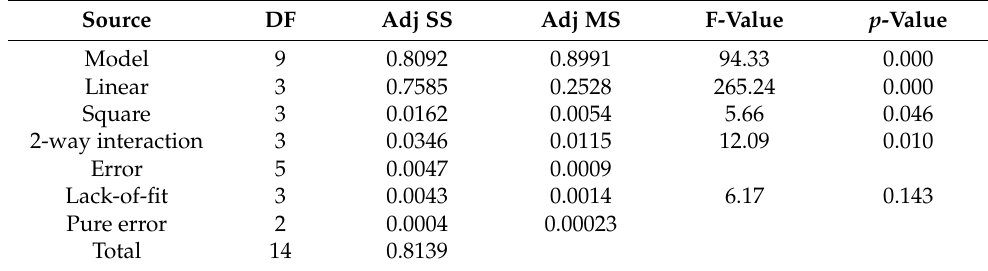
Table 2. ANOVA for MRR in MECDM.